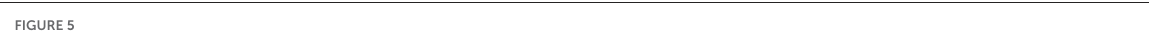
FIGURE5 (lowest concentration measured) to 1 (highest concentration measured). The colors below the dendrogram correspond to the experimental days. The dendrogram shows a separate cluster for the last two days of experiment (days 5 and 6). Principal Component Analysis (PCA) (B) showing the variance of the metabolite composition in the rumen fluid. The graph is based on the normalized values calculated in MetaboAnalyst over the six experimental days.